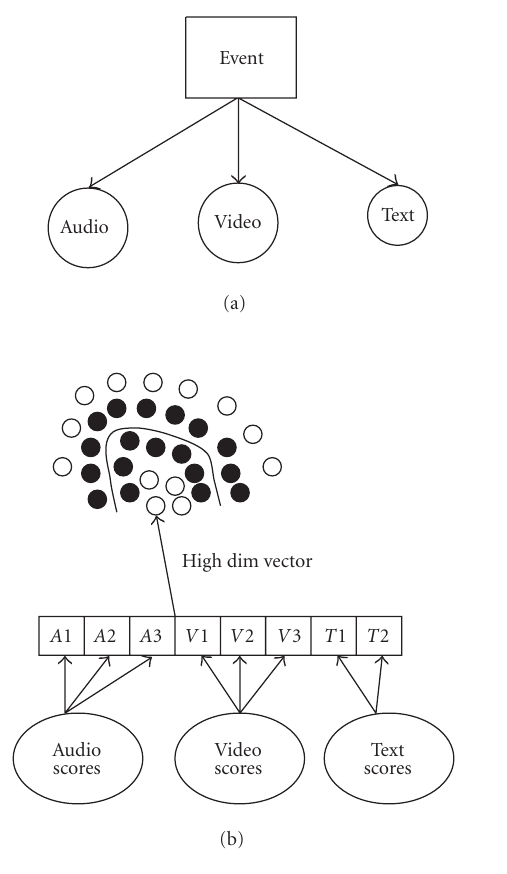
Figure 3: Combining information from multiple intermediate con- cepts (a) Bayesian networks and (b) Support vector machines.